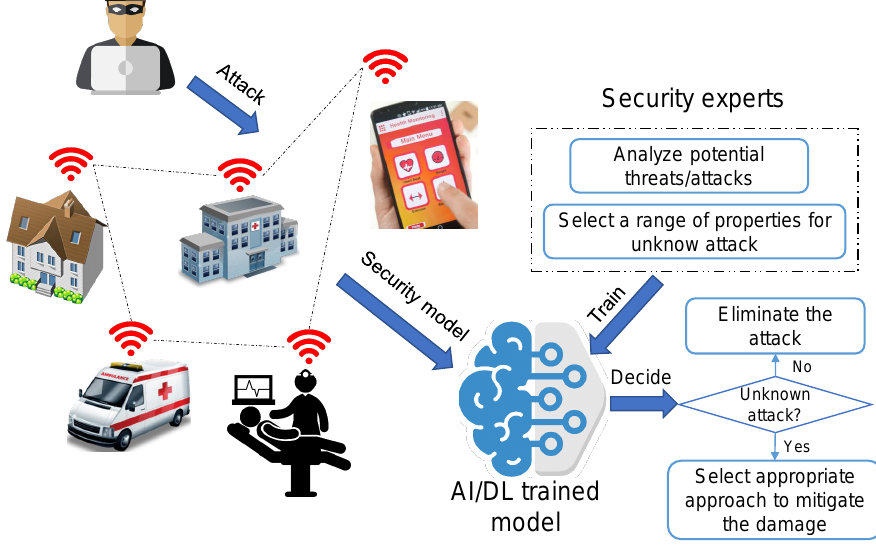
Figure 11. Smart security model for IoT in healthcare